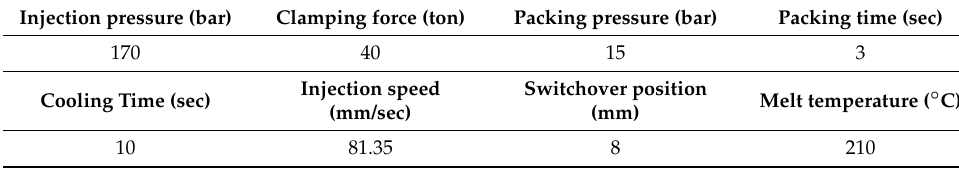
Table 9. The experiment parameters with the adaptive adjustment